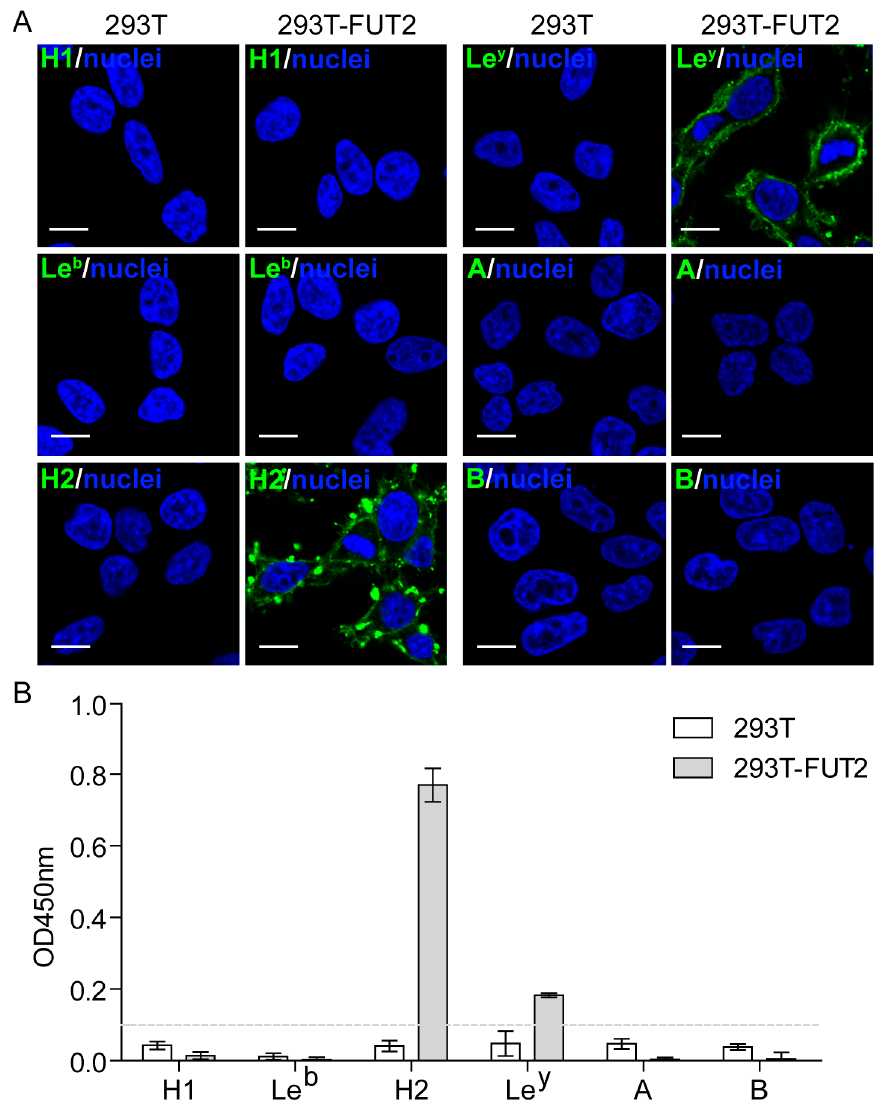
Figure 2. Expression of histo-blood group antigens (HBGAs) in 293T-FUT2 cells. Wild-type 293T cells and transduced 293T-FUT2 cells were examined for their HBGA expression through immunofluorescence analysis and cellular enzyme-linked immunosorbent assay (ELISA) using monoclonal antibodies specific to each of six types of HBGAs (H1, Le b , H2, Le y , A, and B) as described in Materials and Methods. ( A ) Immunofluorescence analysis of HBGA expression in 293T-FUT2 cells. Scale bar, 10 µ m. ( B ) Cellular ELISA analysis of HBGA expression in 293T-FUT2 cells. Data are the means ± SD of the optical density at 450 nm (OD 450nm ) values subtracted from the blank value (cells without incubation with primary antibody) for quadruple wells. The dash line indicates the cutoff, which is defined as 0.1 OD unit above the blank. All of the experiments were replicated three times.